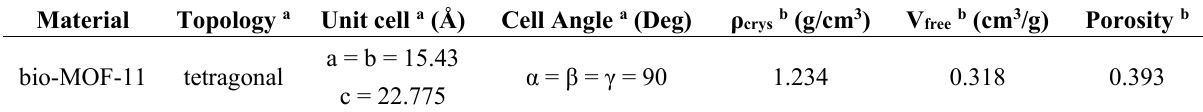
Table 1. Structural properties of bio-MOF-11 studied in this work.